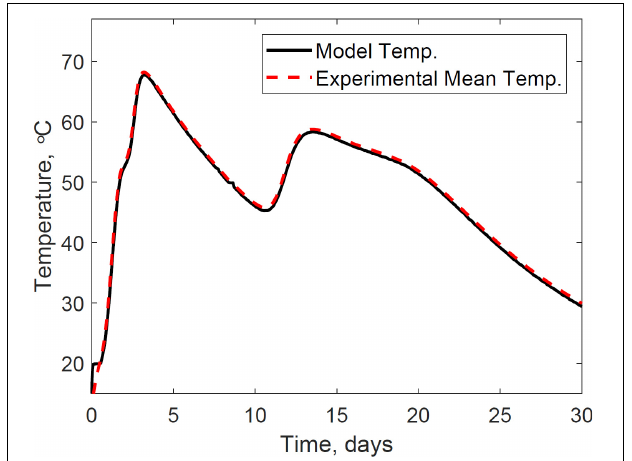
FIGURE 8 | Reactor 2 temperature calibration of the system dynamics model. The model inputs are 347 cc.min − 1 airflow rates, 30% initial moisture